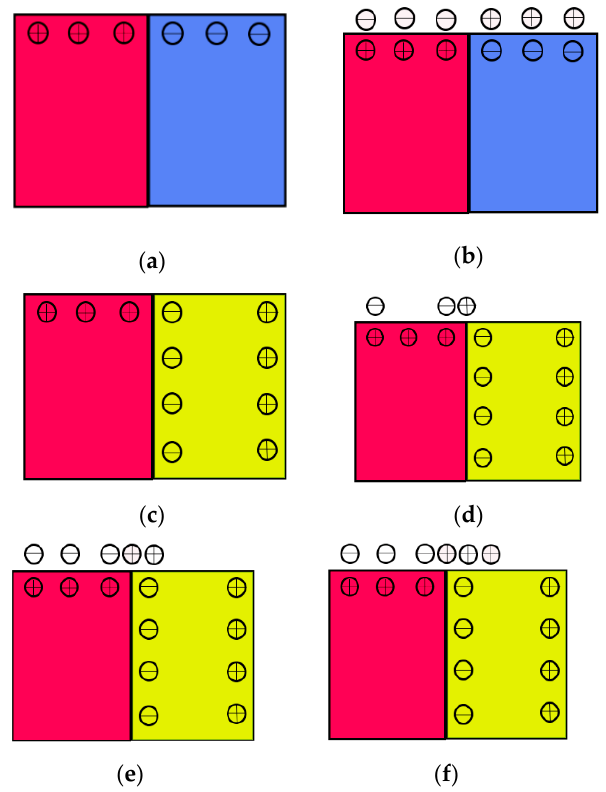
Figure 7. Schematic of surface charge and the screening charge mobility on ferroelectric surface. ( a , b ) The surface charge and the screening of c domain surface, ( c – f ) the surface charge mobility of a-c domain.